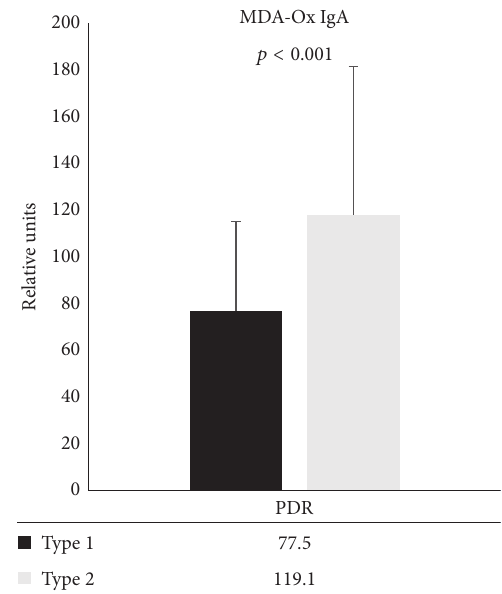
Figure 3: IgA autoantibody levels against MDA-oxLDL (MDA-Ox IgA)inmacularedemapatients(DME)andproliferativeretinopathy (PDR) patients divided by diabetes types (type 1 and type 2). The levels are expressed as mean relative units and standard